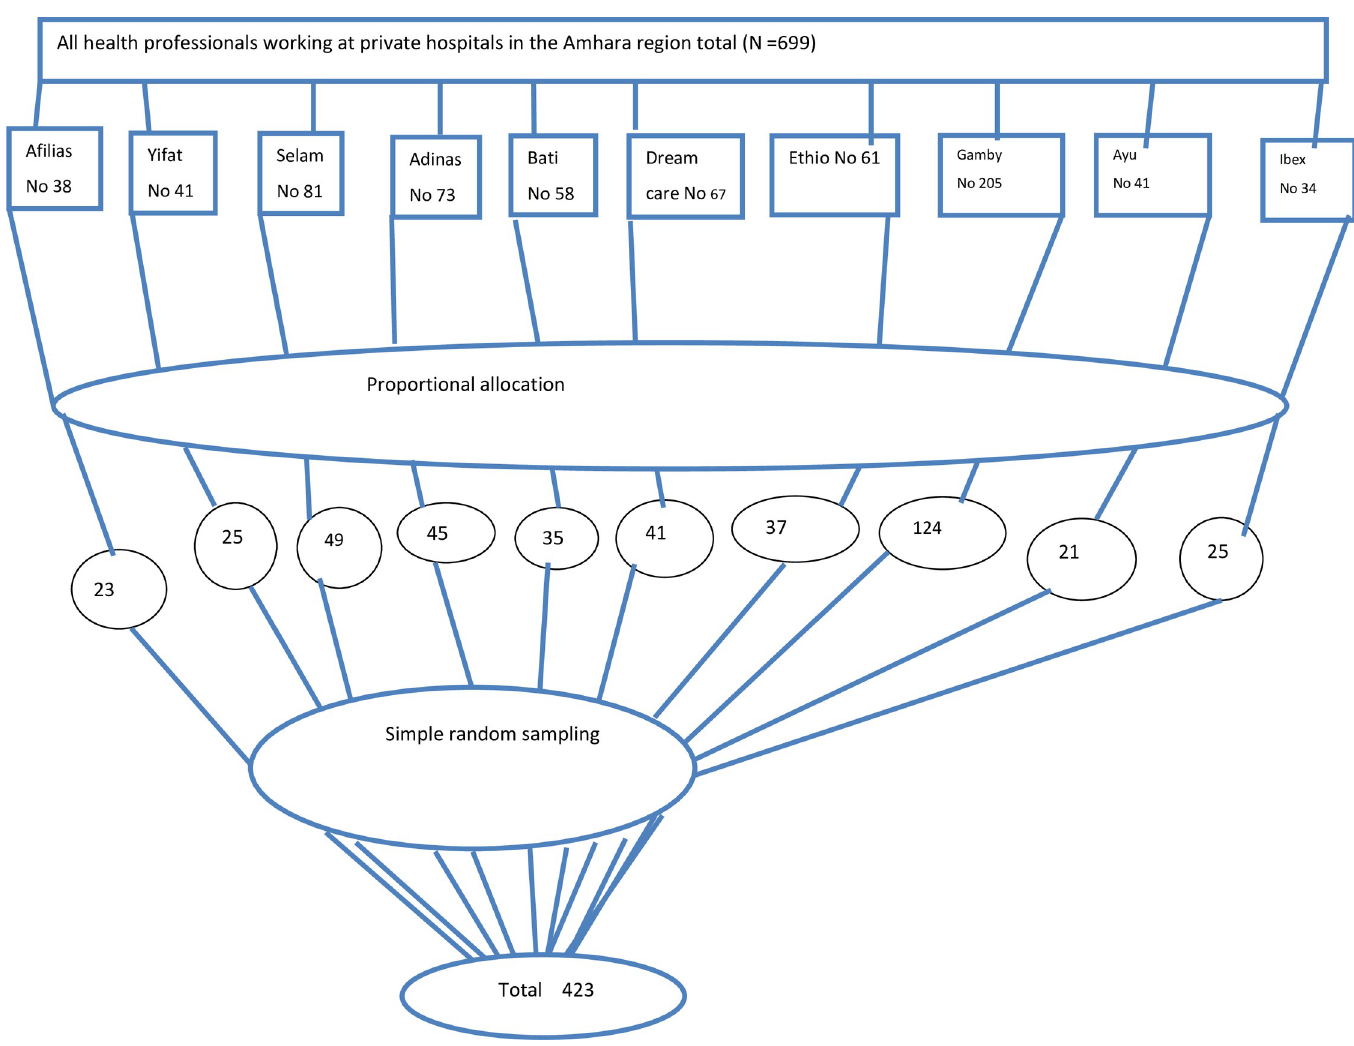
Fig 1. Sampling procedure for selecting study participants at private hospitals in Amhara region, Ethiopia